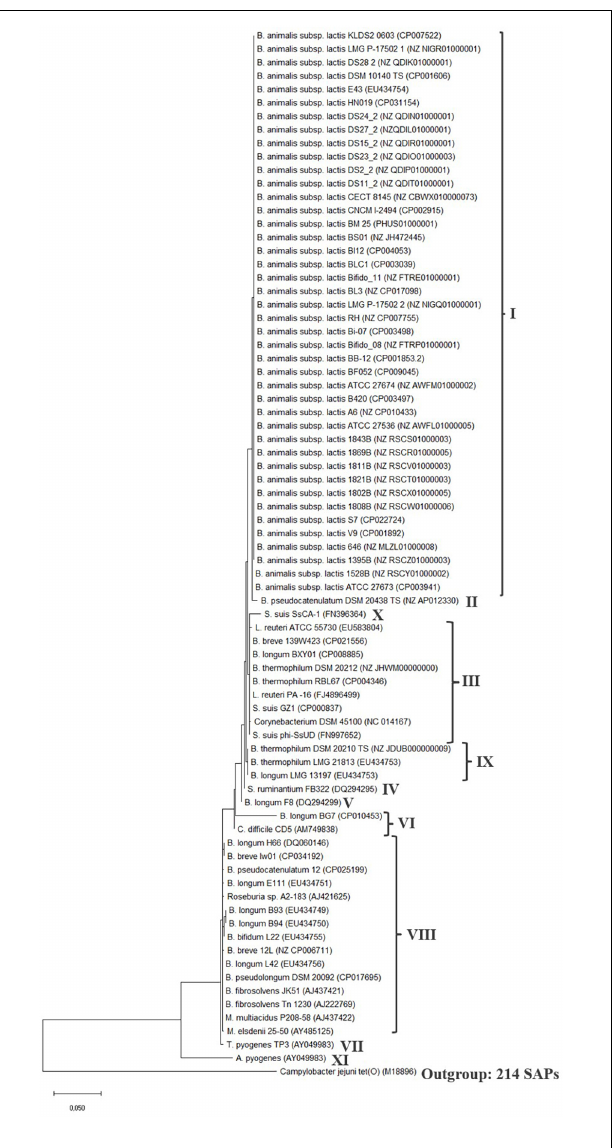
FIGURE 2 | tet (W) protein phylogenetic tree. The tree was built by evolutionary analysis by maximum likelihood method and JTT matrix-based model (Jones et al., 1992; Kumar et al., 2018). The branch lengths are measured in the number of substitutions per site. Strain name and genome or tet (W) gene accession number is provided for the sequences. Type strains (TS) are included for the species, when the type strain encodes tet (W). Clades are defined by the number of SAPs, which can be seen in Table 2 . The phylogenetic tree was rooted with the ribosomal protection gene tet (O) from Campylobacter jejuni (M18896) as an outgroup and similar results was obtained with the Streptococcal ribosomal protection gene tet (M) (X04388) (data not shown) (Levy et al.,